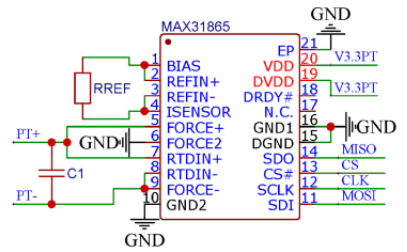
Figure 2. Schematic diagram of the temperature conditioning circuit. To measure the RTD resistance, the MAX31865 connects a reference resistor (RREF) in series with the RTD, and applies a bias voltage to the RREF. Then, the reference resistor’s current flows through the RTD. The voltage across the reference resistor represents the reference voltage for the ADC. Both ends of the RTD resistor are connected to the ADC differential inputs (PT+ and PT − ), and thus, the digital output (Or) generated by the ADC is equal to the ratio of the RTD resistance to the reference resistance, which can be expressed by: